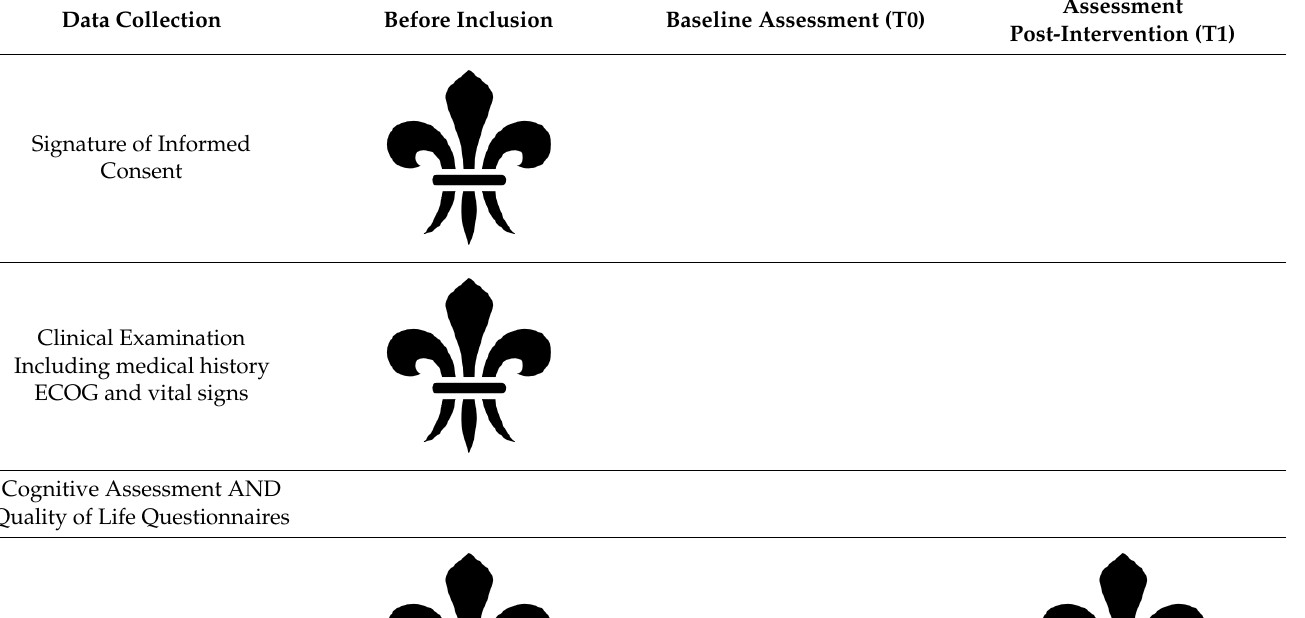
Table 1. Details concerning data collection.